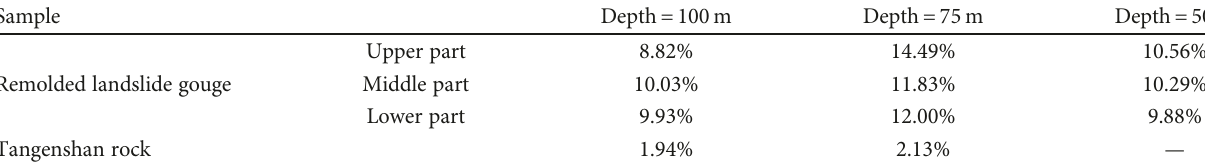
Table 4: Water content of the samples after ring shear